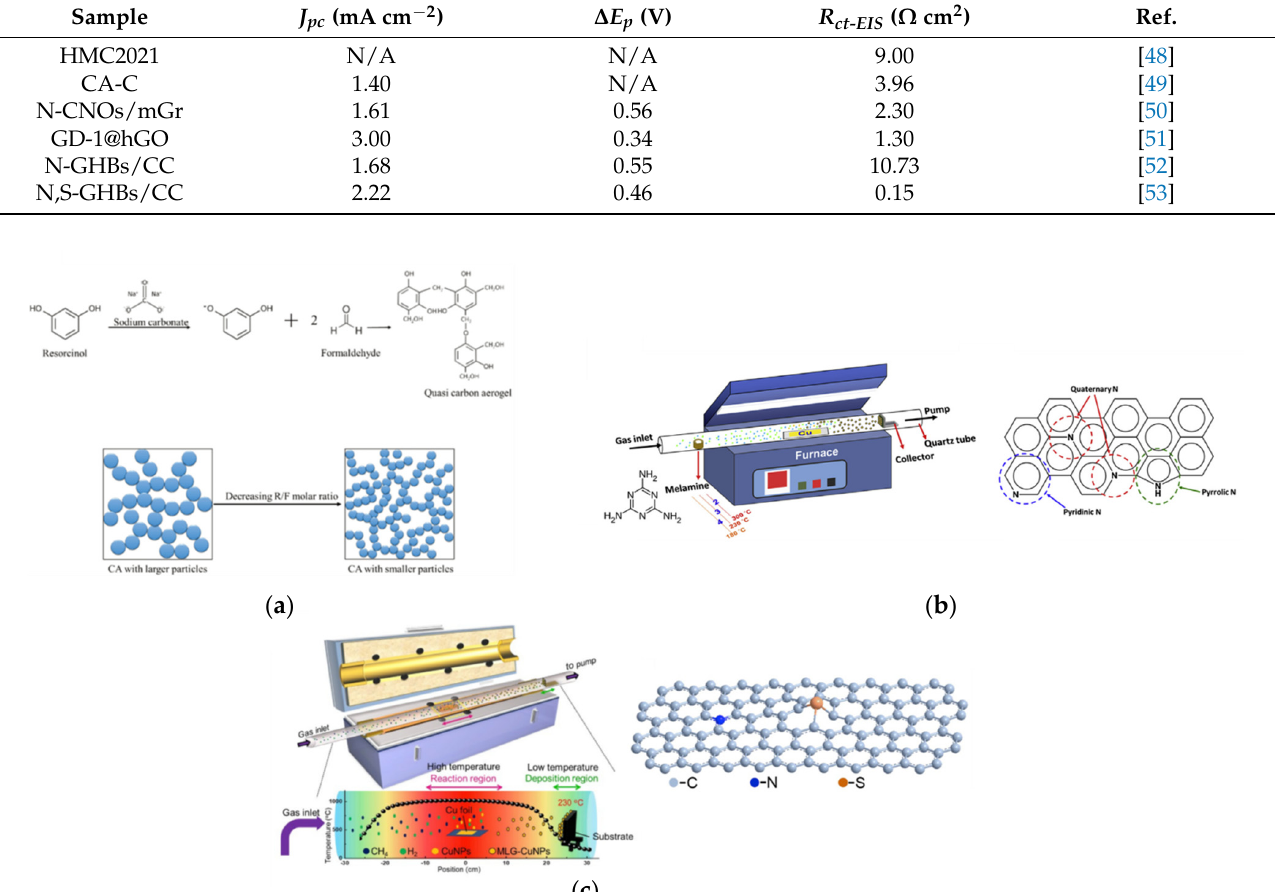
Figure 4. ( a ) Molecular equation of the additional reaction and the effect of the R/F molar ratios on the CA particles [49]. ( b ) Scheme of the CVD design for the growth of N-GHBs; three types of the N-doped states in N-GHBs include pyridinic N, pyrrolic N, and quaternary N [52]. ( c ) Scheme shows the growth of GHBs on CC in a CVD reactor at 1090 °C and the temperature profile inside the quartz tube of the CVD system [53].